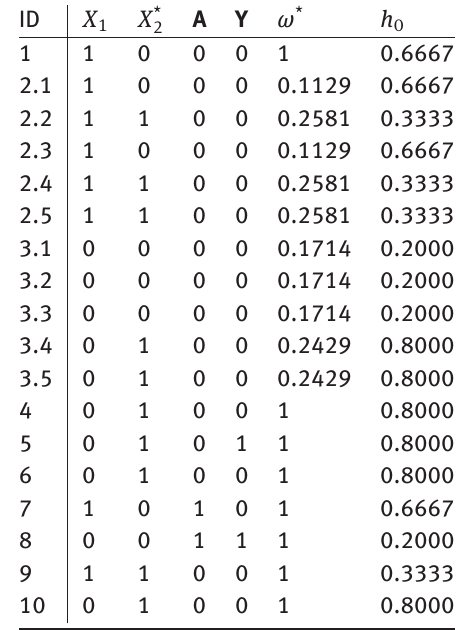
Table A4: Updated data after the first W-step.